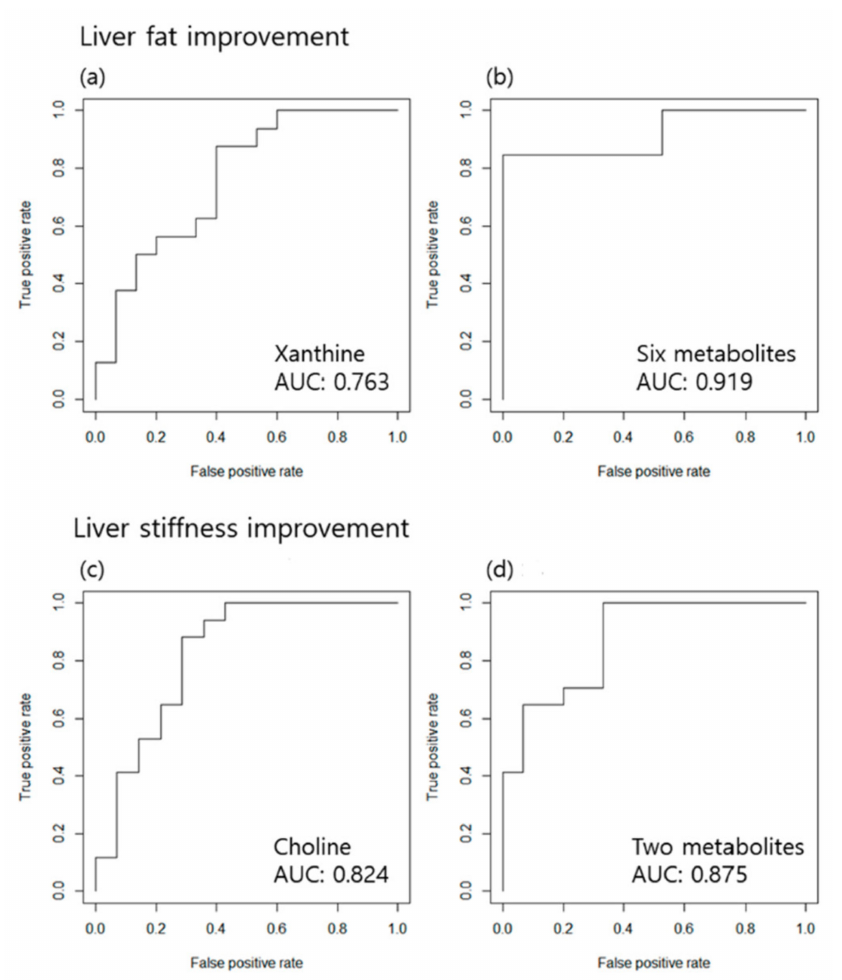
Figure 3. ROC analysis and AUC values for classifying good responders using the relative change in metabolite levels. Prediction of liver fat improvement measured by MRI-PDFF in the ( a ) ezetimibe + statin group and ( b ) statin group. Prediction of liver stiffness improvement measured by MRE in the ( c ) ezetimibe + statin group and ( d ) statin